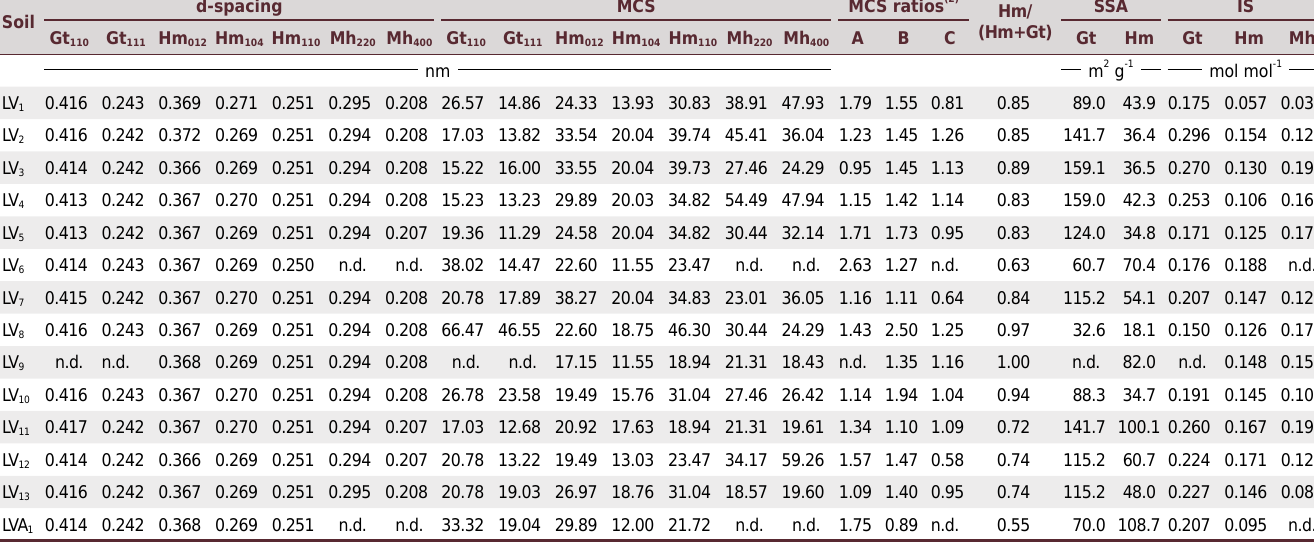
(1) d-spacing corrected using silicon as an internal standard. Hm/(Hm + Gt), MCS, SSA and IS ratios were calculated from the X ray patterns of the concentrated Fe oxides; n.d. not detected; (2) Ratios calculated from the MCS values: A = MCS Gt110 /MCS Gt111 , B = MCSa/MCSc = (MCS Hm110 × 0.72)/ (MCS Hm012 × 0.59), C = MCS Mh220 /MCS Mh400